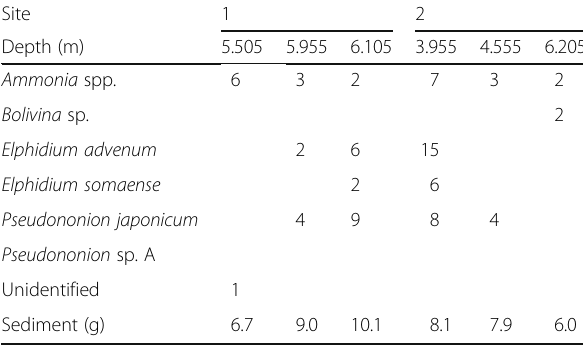
(Figs. 5 and 7). Leaf material in this bed yielded 14 C ages of AD 258 to 428 (Fig. 4, Table 1). GPR reflections show parallel to seaward dipping layers that indicate prograd- ation of the beach ridge and shoreline (Fig. 3). Discussion